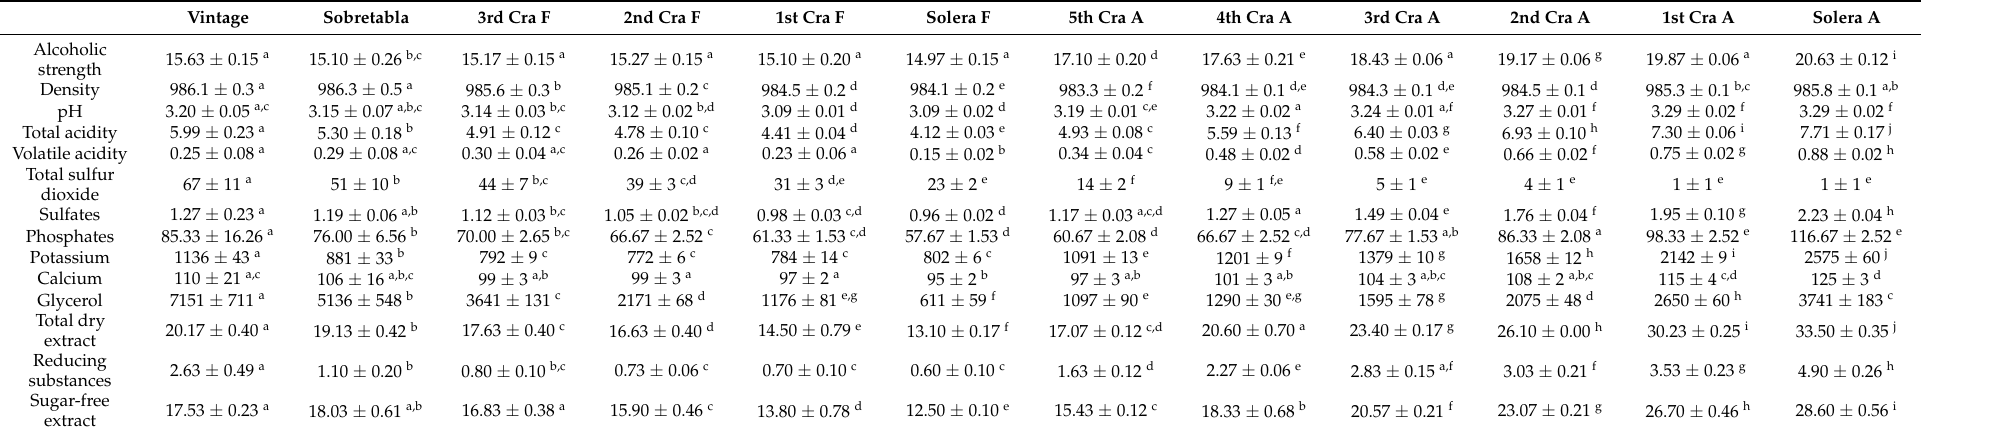
Table 2. Oenological control parameters: alcoholic strength (%vol.), density (g/L), pH, total acidity (g TH 2 /L), volatile acidity (g AcH/L), glycerol (mg/L), total sulfur dioxide (mg/L), sulfates (g K 2 SO 4 /L), phosphates (mg PO 4 /L), potassium (mg/L), calcium (mg/L), total dry extract (g/L), reducing substances (g/L)